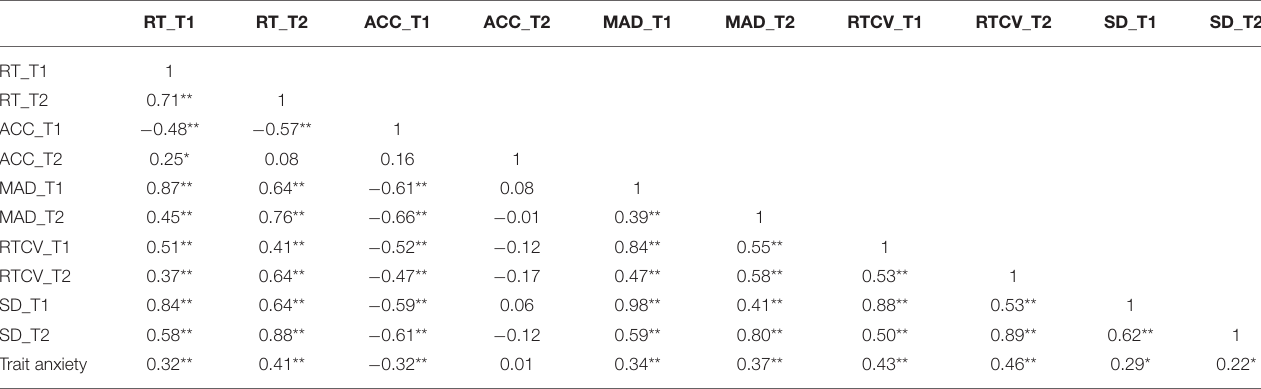
TABLE 3 | Partial correlations among different study